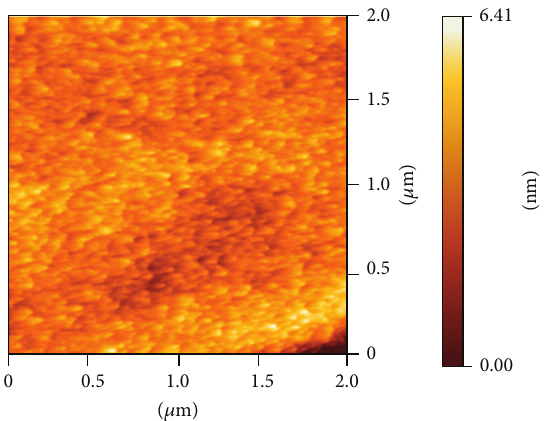
Figure 4: TEM images illustrate the formation of jasmine bud- shaped PVP capped copper nanoparticles in 100nm